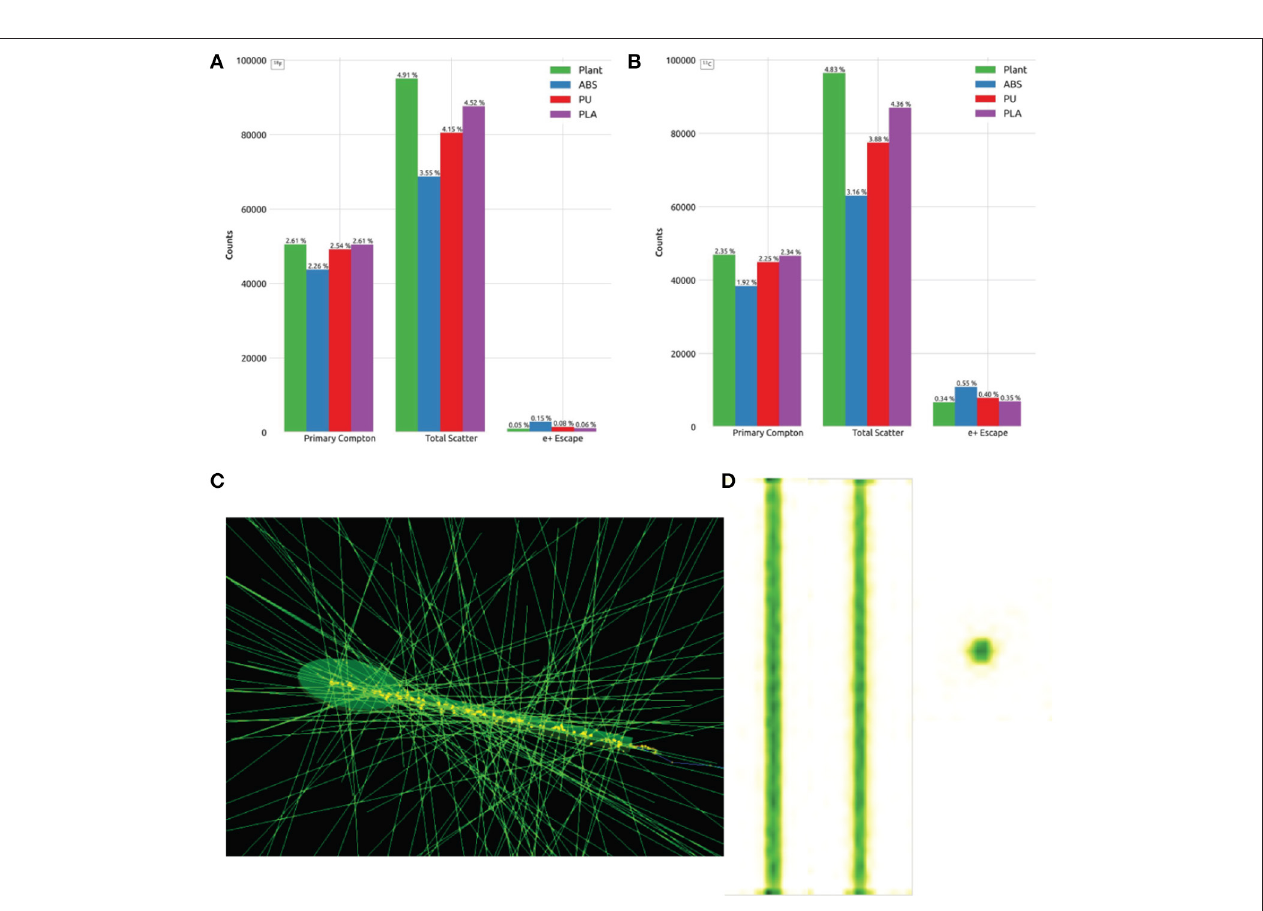
FIGURE 6 | De Renzo imaging of the CONC system. A De Renzo phantom is placed at the center of the FOV and at a shift of the system.